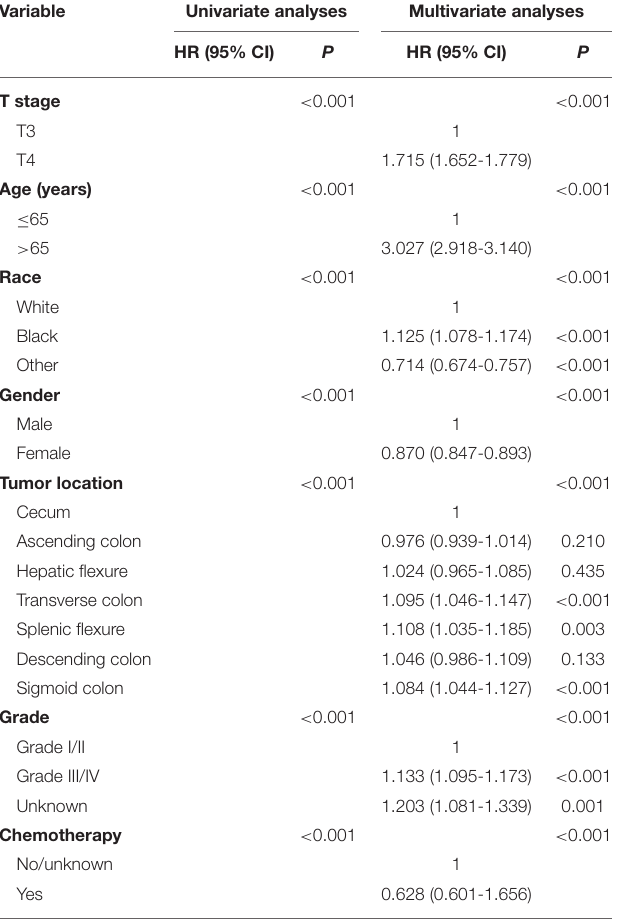
TABLE 3 | Univariate and multivariate analyses of prognostic factors in stage II NMUA. Variable Univariate analyses Multivariate analyses